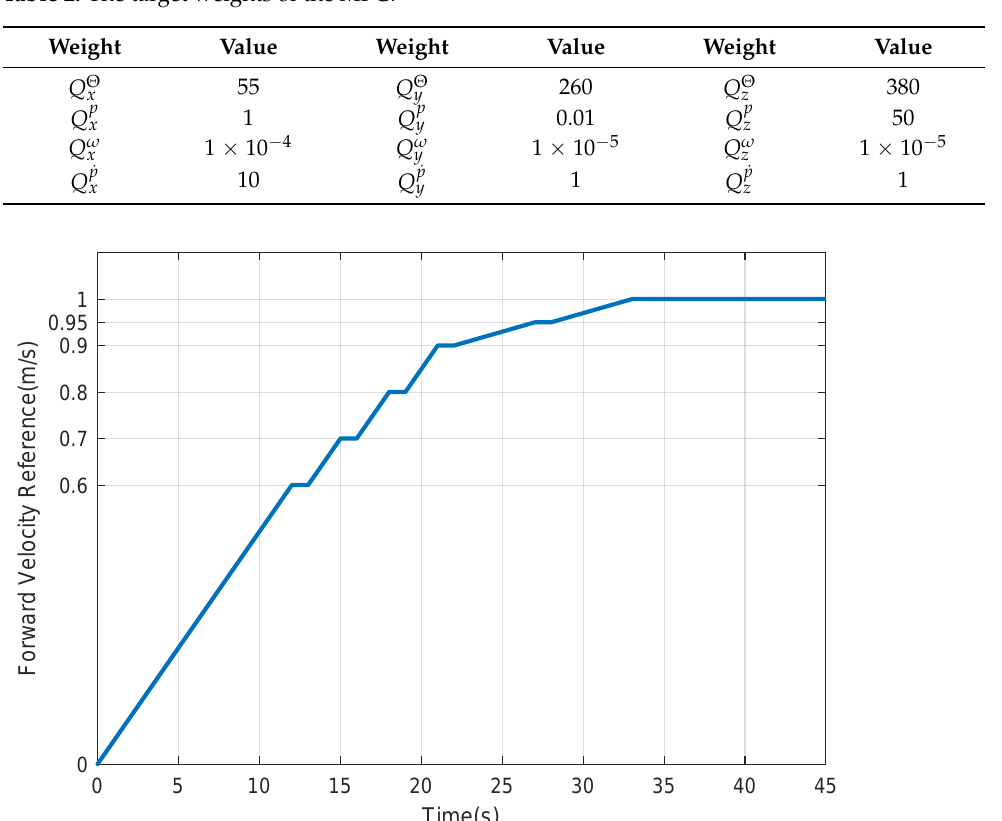
Table 2. The target weights of the MPC.